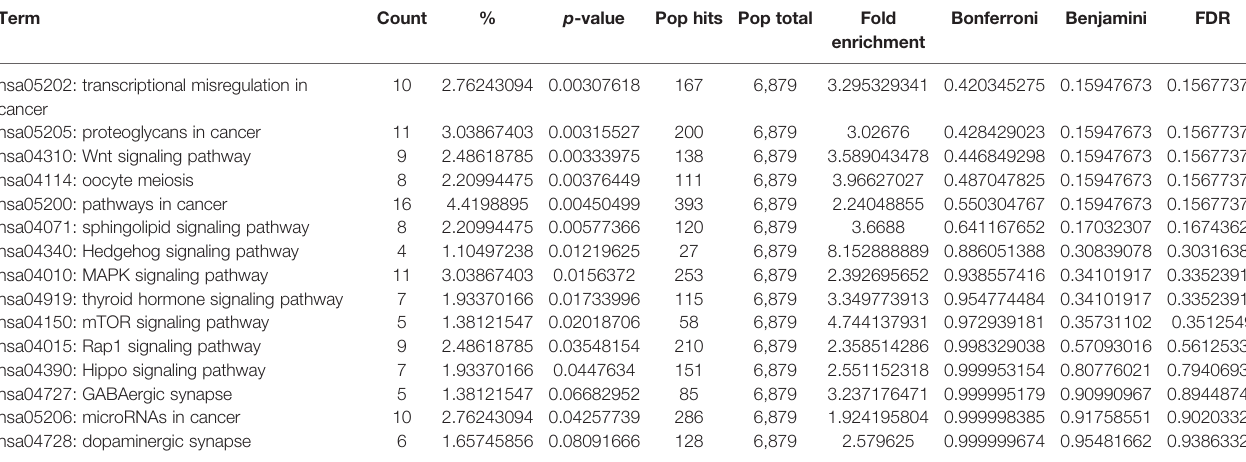
TABLE 4 | Top 16 KEGG pathway enrichment for targets of candidate